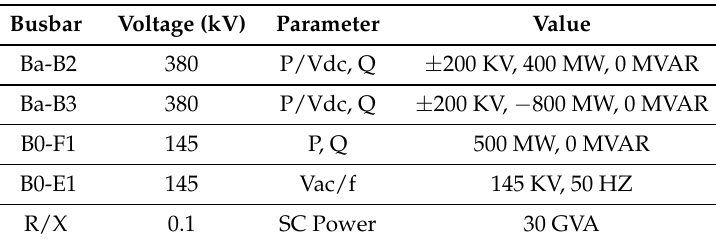
Figure 4. Construction of HVDC cable bundle used in simulation cases. Table 1. The parameters of the simulated HVDC model.